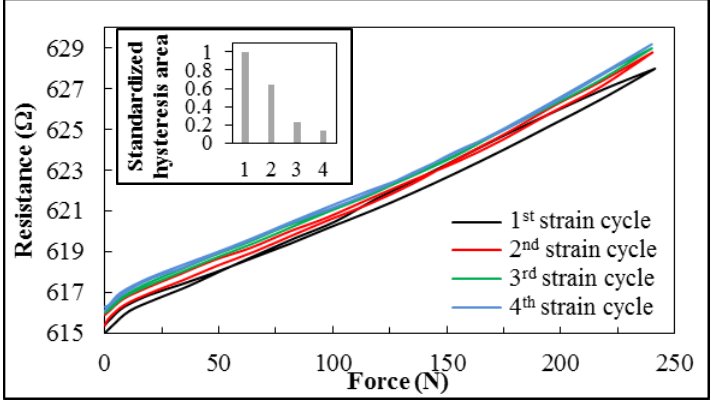
Figure 8. Hysteresis effect of resistance–force response during first four cycles of loading and unloading the strain gauge. The bar chart points out the change in area of the hysteresis